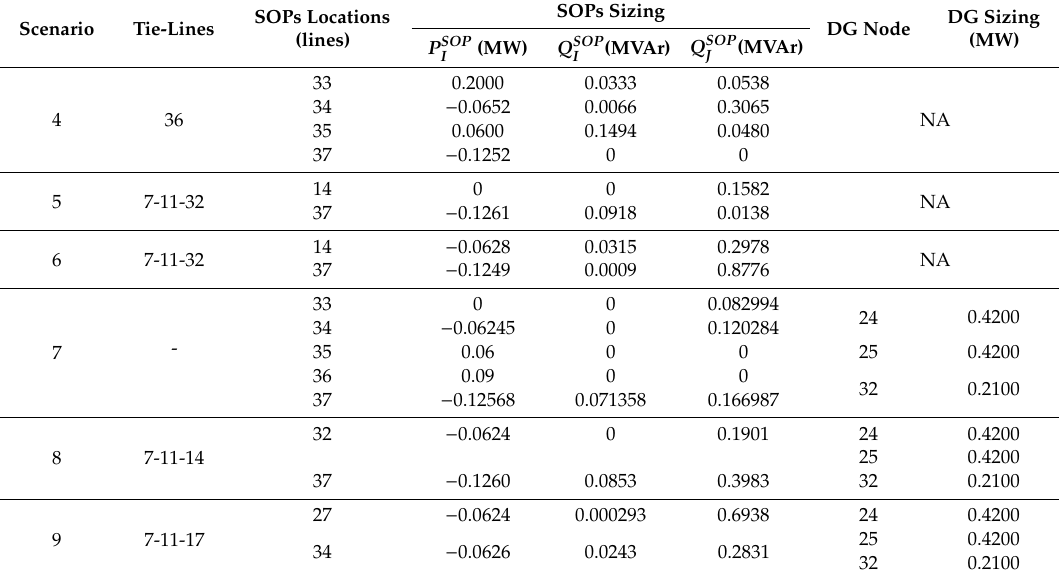
Table A2. Optimal system configuration, sizing, and locations of SOPs and DGs for scenarios 4 to 9 with SOPs internal losses considered at normal loading level: IEEE 33-node distribution